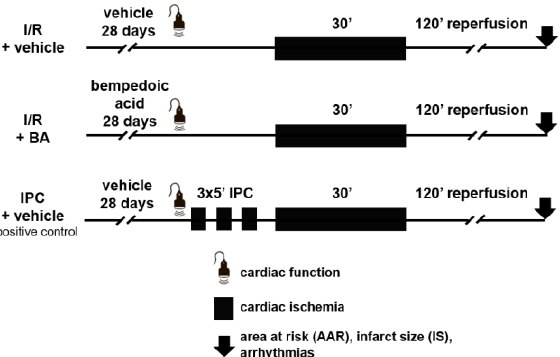
Figure 1. Experimental protocol. Rats were treated with vehicle or bempedoic acid for 28 days per os. After the treatment period, echocardiography was performed. Myocardial ischemia was implemented by occlusion of the left anterior descending coronary artery and area at risk, infarct size and arrhythmias were measured. Ischemic preconditioning (IPC) was used as a positive control. IPC: ischemic preconditioning. I/R: